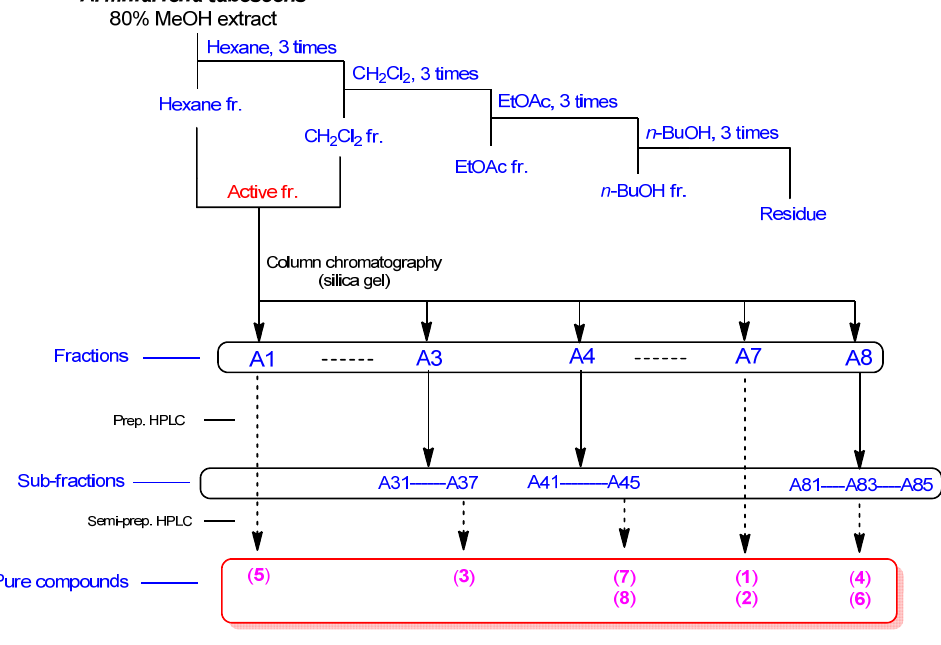
Figure 3. Separation scheme of compounds 1 – 8 .